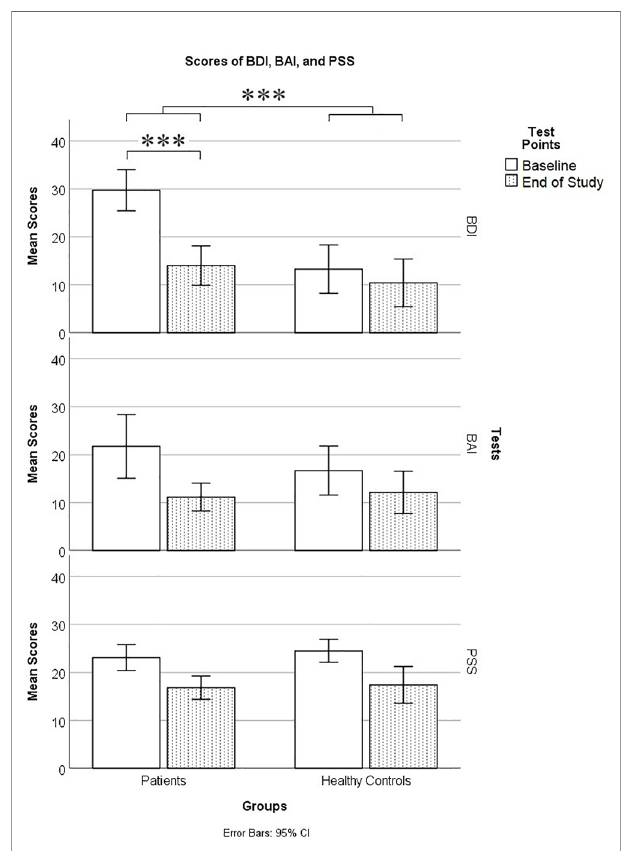
FIGURE 1 | Mood scores on the Beck Depression Inventory II (BDI), Beck Anxiety Inventory (BAI), and Cohen ’ s Perceived Stress Scale (PSS) in patients and controls at baseline and end of study. *** means p ≤